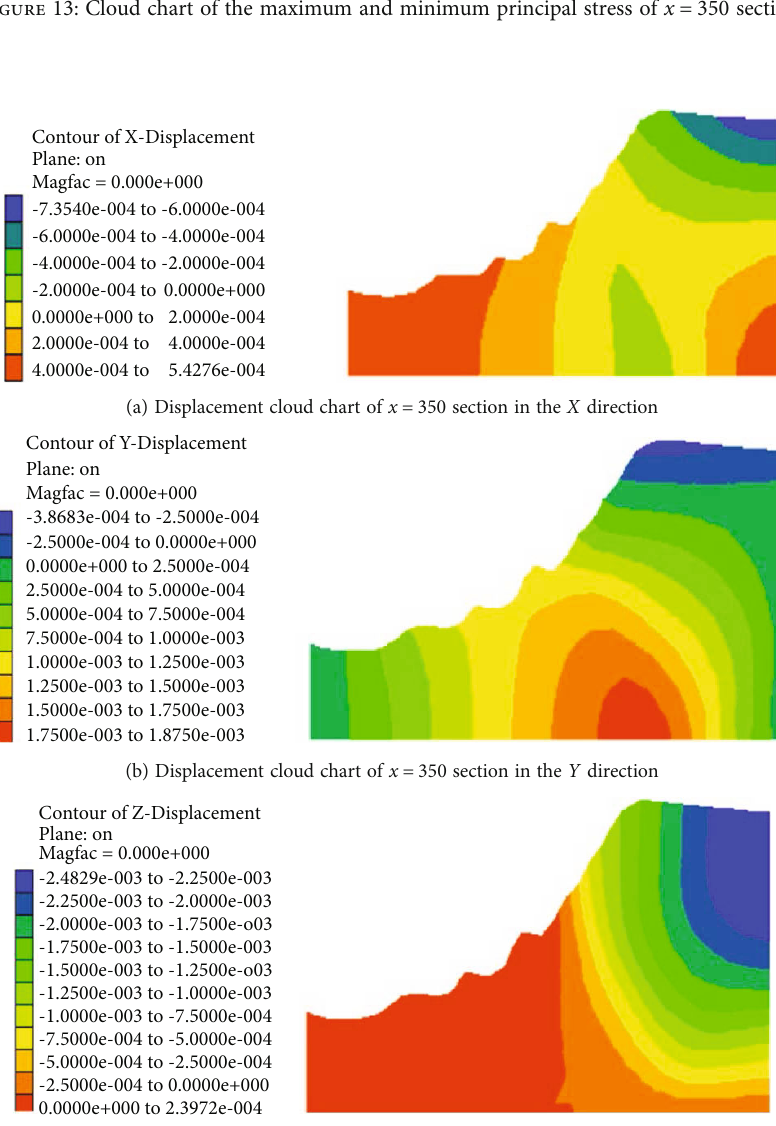
Figure 14: Displacement cloud chart of x = 350 section of the